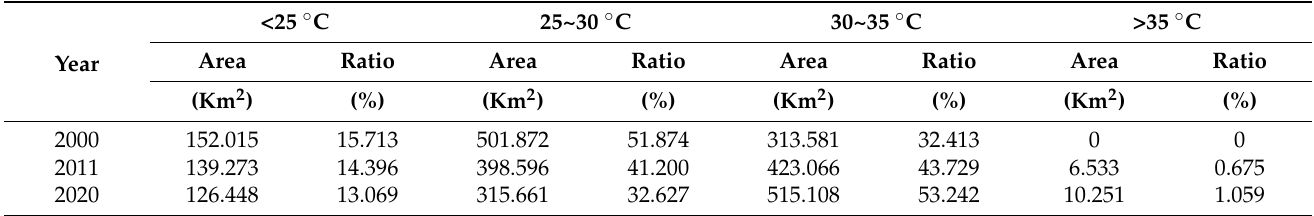
Table 4. Range wise LST distribution in the study area from 2000 to 2020.